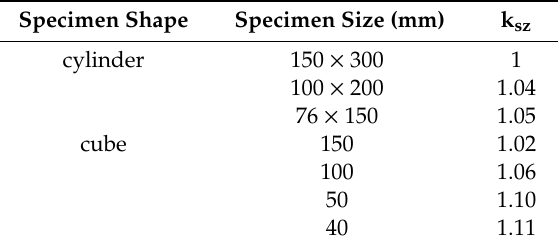
Table 3. Specimen shape and size coe ffi cient k sz